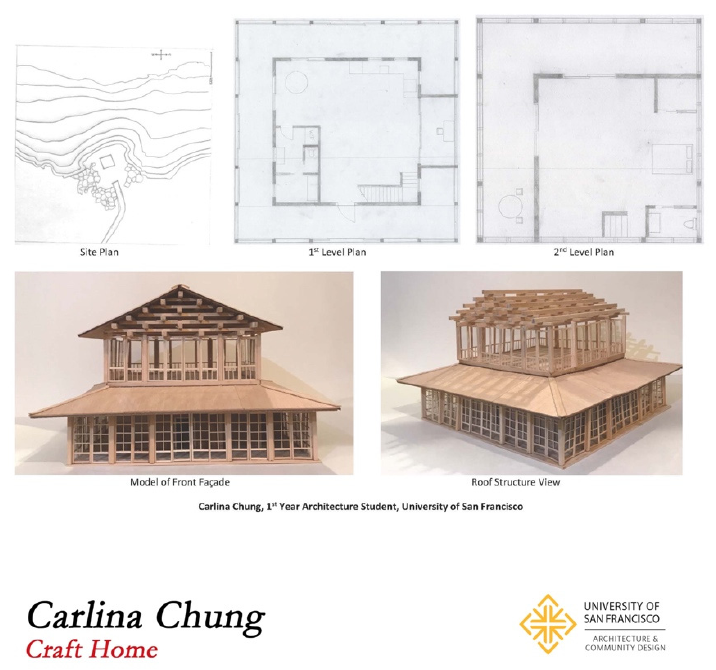
Figure 5. Materials on display in Building Beauty’s HOME Competition, Spring 2019.